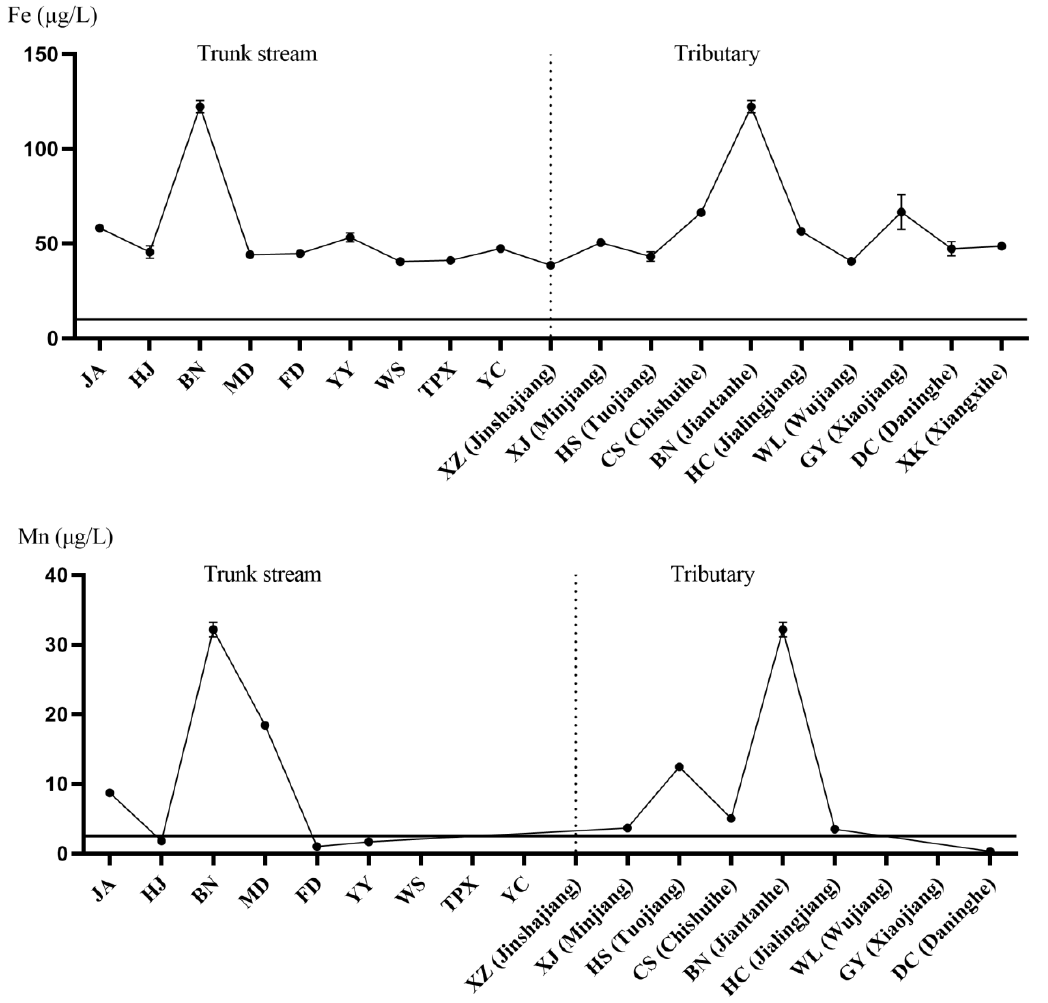
Figure 3. Spatial variance of Fe and Mn ( µ g/L) concentrations in the sampling stations of the Yangtze River. The horizontal and solid lines in the figure represent the background values in historical documents. The x-axis is the sampling point. The left side of the vertical dotted line is the main stream and the right side is the tributaries of the Yangtze River. The y-axis is the element concentration.